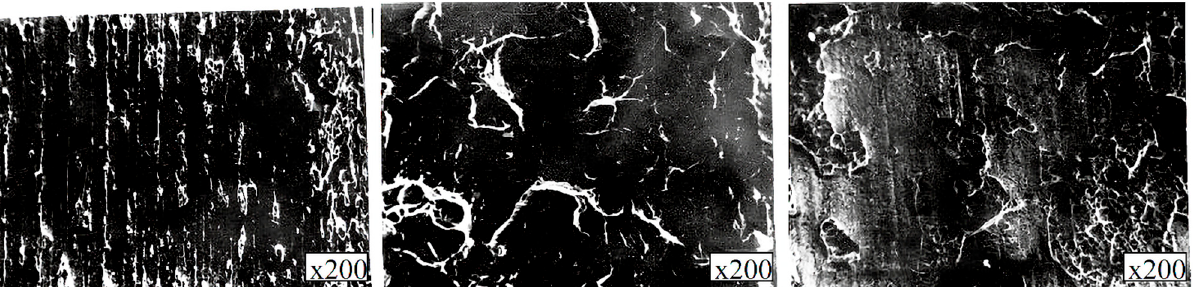
Figure 11. Fractography of the sample surface after destruction.